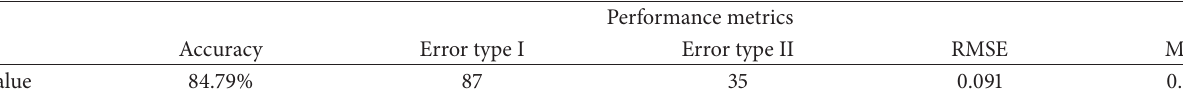
Table 2: The prediction performance of the baseline Cox proportional hazards model.